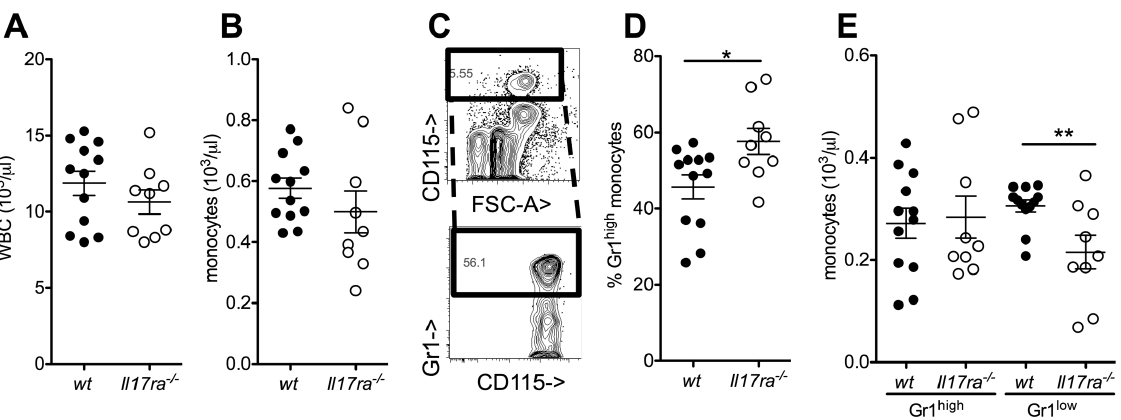
Figure 1. Decreased Gr1 low monocyte counts in IL-17 receptor A deficient mice. ( A,B ) Peripheral blood total white cell (A) and monocyte (B) counts were assessed by an automated analyzer in wild type (wt) and Interleukin-17 receptor A-deficient ( Il17ra -/- ) mice (n=9–12). ( C–E ) Gr1 high and Gr1 low monocyte subgroups were analyzed by flow cytometry after gating for CD11b + CD115 + events (example in C, D: proportion of Gr1 high monocytes and E: absolute concentrations in wt and Il17ra -/- mice, n=9–12, t-tests).